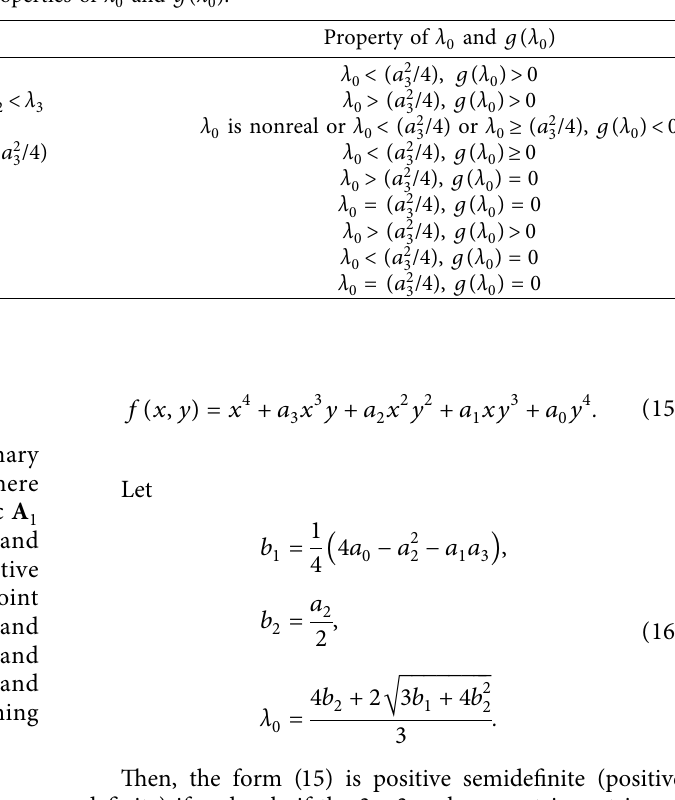
and properties of three roots of det ( M λ